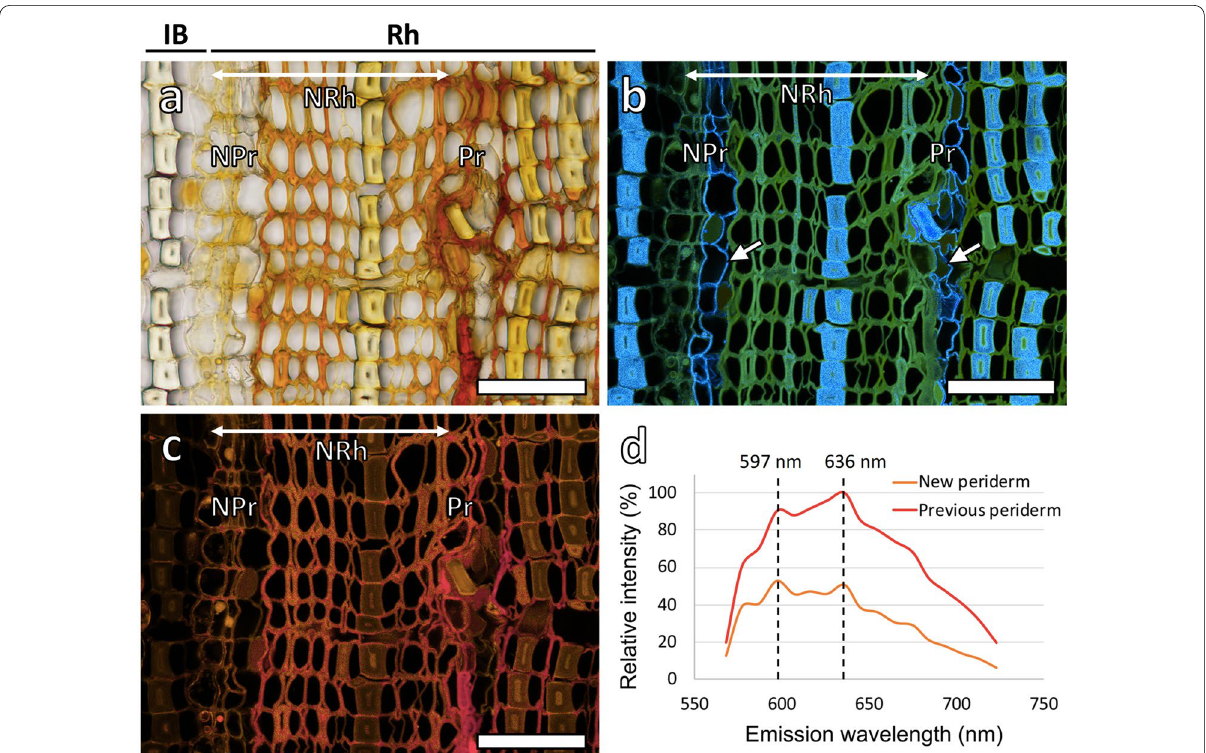
Fig. 6 Bright-field and autofluorescence images showing the new rhytidome at Stage 3 ( a – c ) in Tree B in August, 2016. a A light micrograph of a transverse section without staining. Lambda stack images of autofluorescence under fluorescence excitation at 405 nm ( b ) and 561 nm ( c ) obtained from the section in a . d Averaged emission spectra of autofluorescence under fluorescence excitation at 561 nm from ten randomly chosen pixels that distributed in the cell wall areas of new and previous periderms from the section in a – c . White arrows indicate phellem cells. NPr new periderm, NRh new rhytidome, Rh rhytidome. The right side of each micrograph corresponds to the outer side of the tree. Scale bars